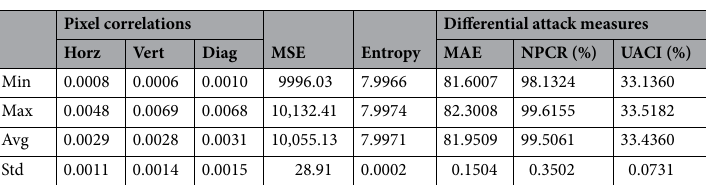
Table 9. Summary of the statistical analysis results for encrypted Peppers using 30 different system keys ( K 1 , K 2 , . . . , K 30 ).